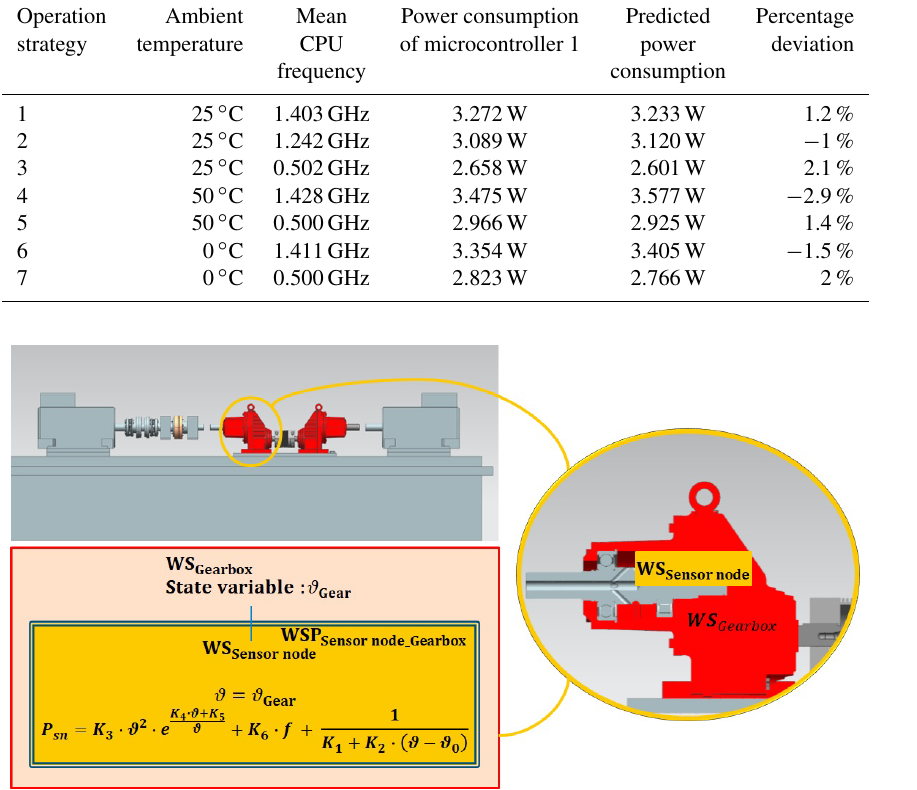
Figure 11. qWSM of the power consumption of the integrated sensor node in the